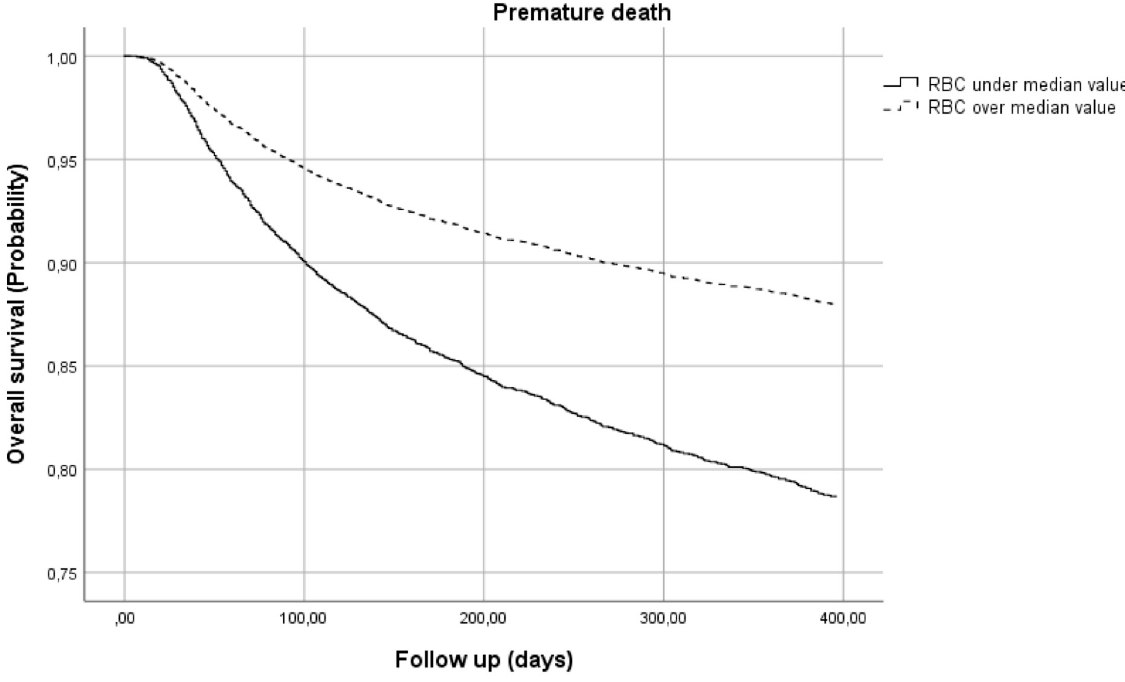
Fig 3. Risk of premature death by red blood cell (RBC)